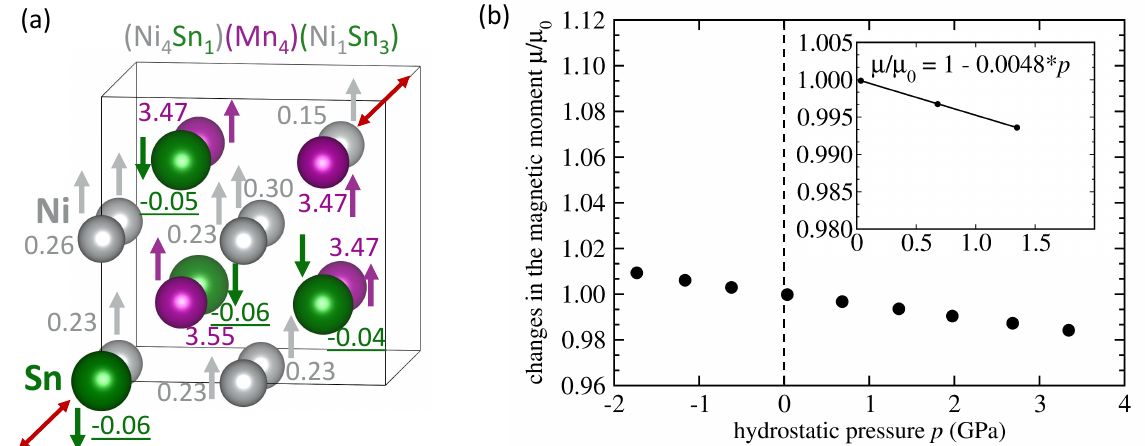
Figure 7. A schematic visualization of a 16-atom computational supercell of the austenitic stoichiometric Ni 2 MnSn with one Sn atoms swapping one Ni atom as indicated by the red arrows ( a ) accompanied by values of local magnetic moments (in Bohr magnetons) corresponding to a minimum-energy zero-pressure state. Part ( b ) shows calculated pressure-induced changes of the total magnetic moment of the state shown in part ( a ) together with the corresponding linear